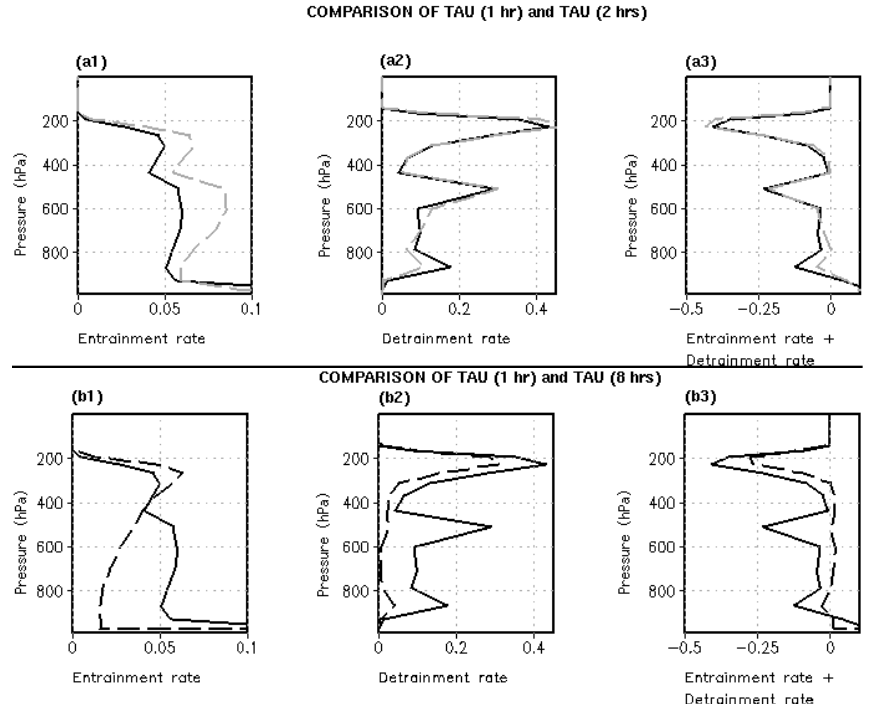
Fig. 4. Top panel shows the comparison of TAU (1h) and TAU (2h), and bottom panel shows the comparison of TAU (1h) and TAU (8h). (a1) and (b1) show the vertical profile of area (0 ◦ E to 360 ◦ E and 12.5 ◦ S to 12.5 ◦ N) averaged updraft mass entrainment rate (per day), (a2) and (b2) show the vertical profile of area (0 ◦ E to 360 ◦ E and 12.5 ◦ S to 12.5 ◦ N) averaged -ve updraft mass detrainment rate, (per day), and (a3) and (b3) show the vertical profile of area (0 ◦ E to 360 ◦ E and 12.5 ◦ S to 12.5 ◦ N) averaged updraft mass entrainment and detrainment rate, (per